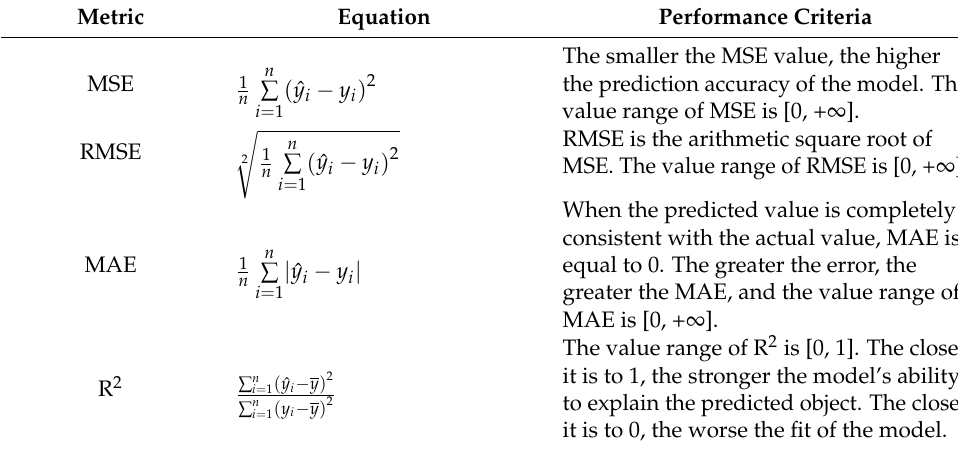
Table 6. Description of evaluation metrics 1 .